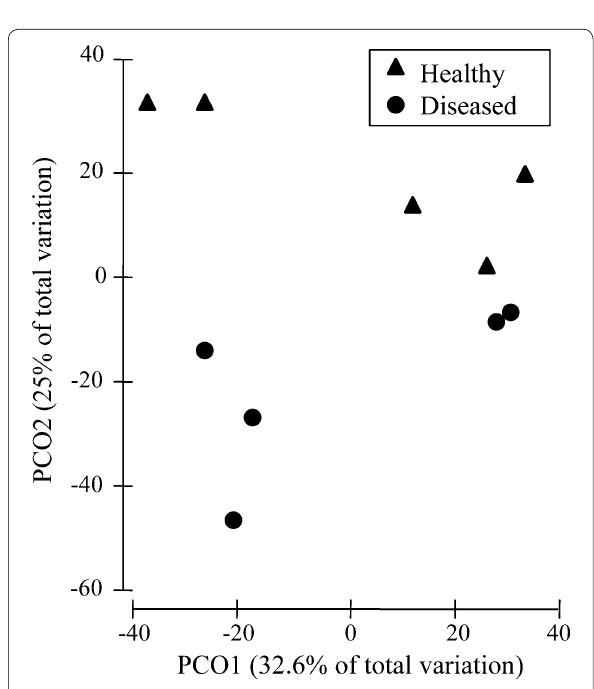
Fig. 3 PCoA analysis for the dissimilarity (Bray–Curtis distance) intestinal bacterial community composition of mud crab (